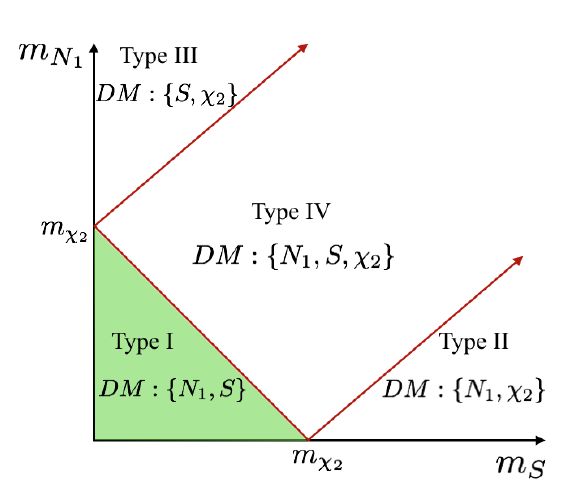
Figure 2 . Di(cid:11)erent types of multicomponent DM scenarios that can be realised in the model depicted in m N m S plane, given that a hierarchy among m N 1 (cid:0) in green) is analysed in this